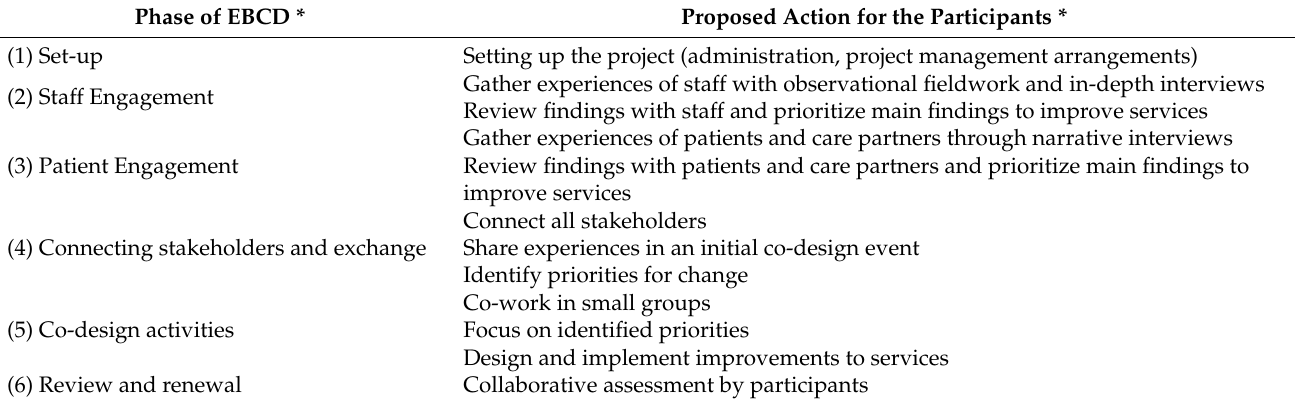
Table 1. Phases of experience-based co-design